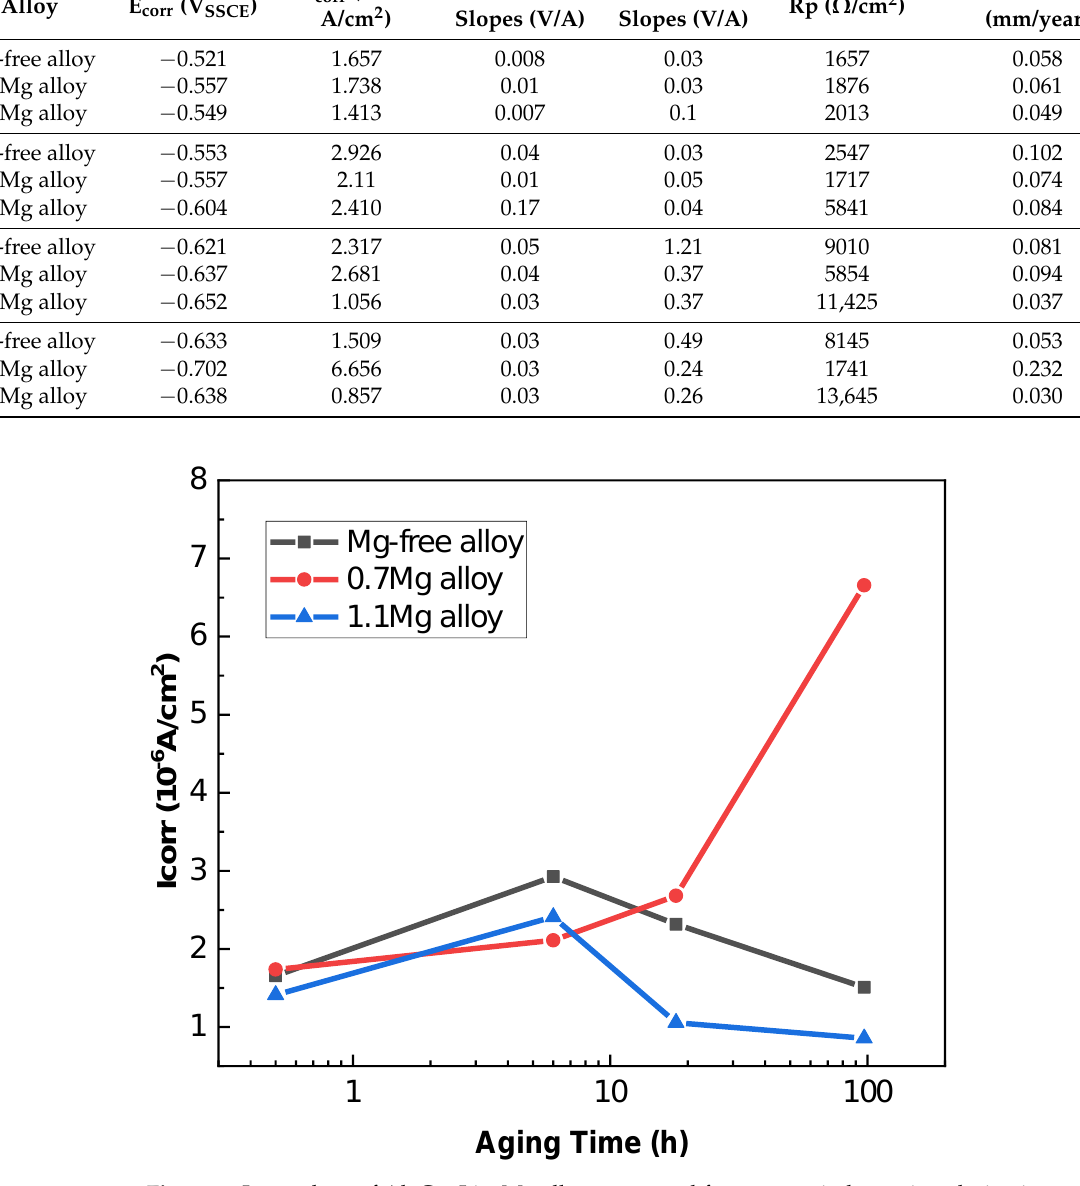
Figure 3. I corr values of Al–Cu–Li– x Mg alloys extracted from potentiodynamic polarization studies in Figure 2.